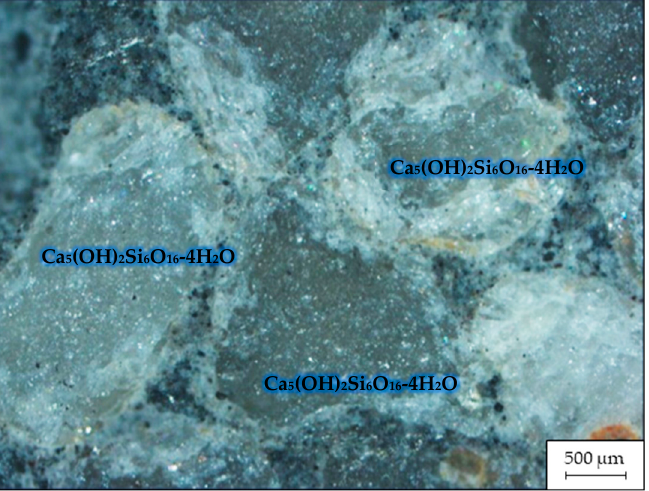
Figure 3. Microstructure of a fracture of the RHC sample containing MCU-95.